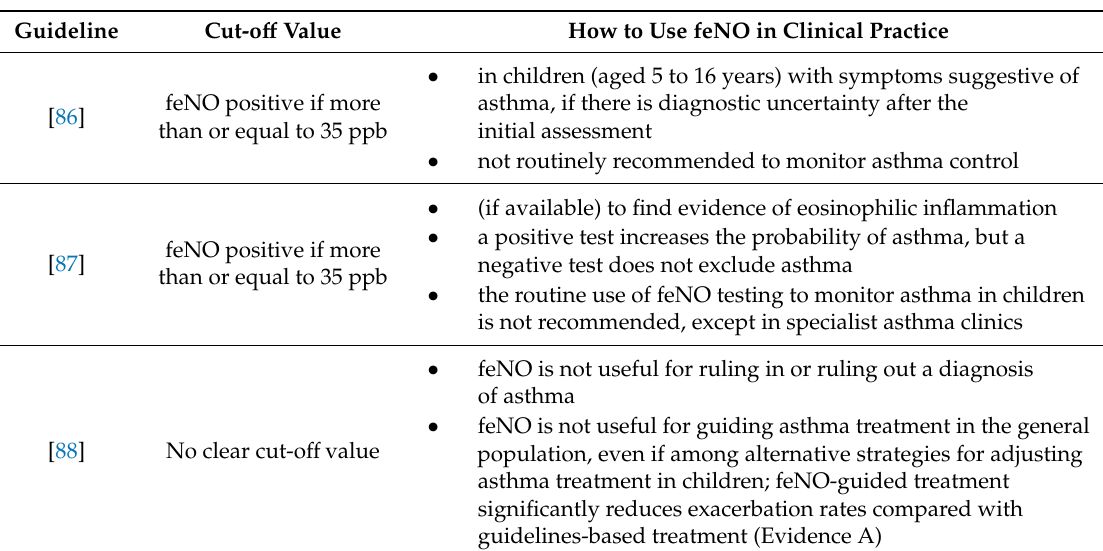
Table 2. How guidelines consider the use of fractional exhaled nitric oxide (feNO) as a biomarker of asthma